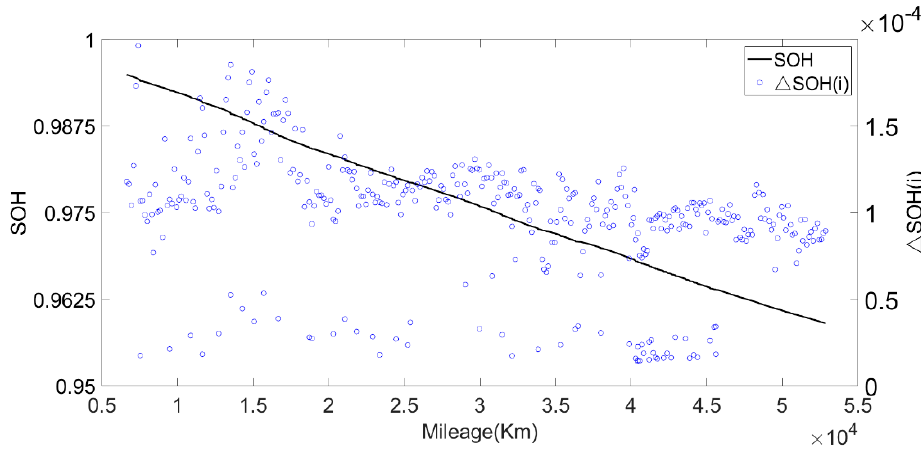
Figure 20. The relationship between SOH, ΔSOH and mileage.